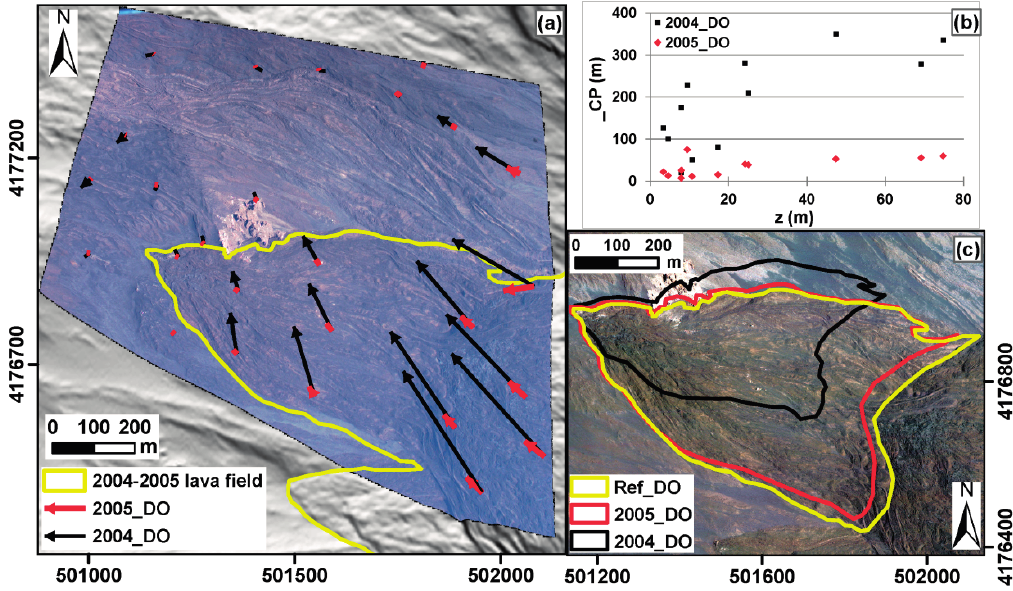
Figure 8. Test 2—2006 lava flows in Valle del Bove (Mt Etna): ( a ) Displacement vectors of CPs measured on the DO with ID 297 obtained using the 2005 DEM and the 2004 DEM (red and black arrows, respectively). The yellow line indicates the area covered by the 2004–2005 lava field; ( b ) Graph showing the magnitude of the displacements in the modified area as a function of the height variations; ( c ) Comparison between flow limits drawn on the reference orthophoto (yellow), as well as on the 2005 and 2004 DOs (red and black,